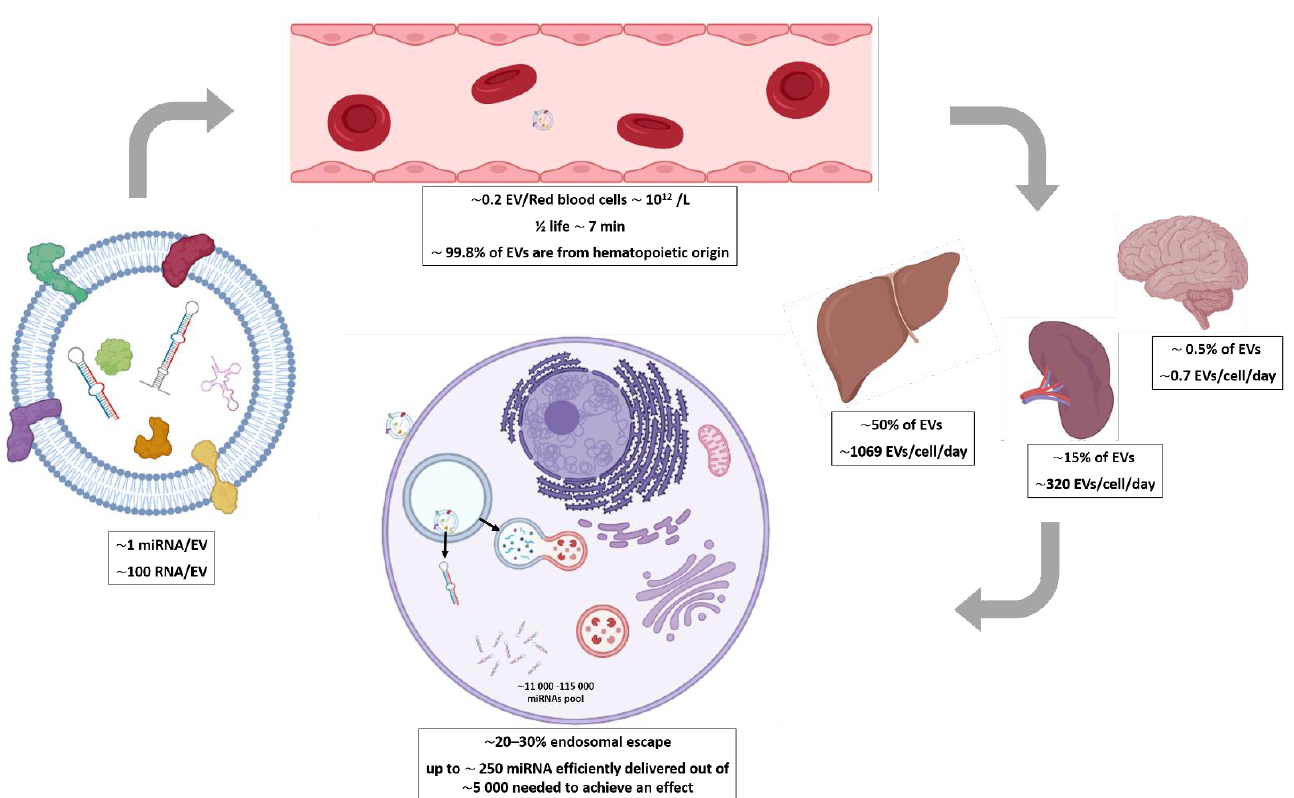
Figure 1. Summary of key numbers about RNA transfer via EVs in physiological conditions.